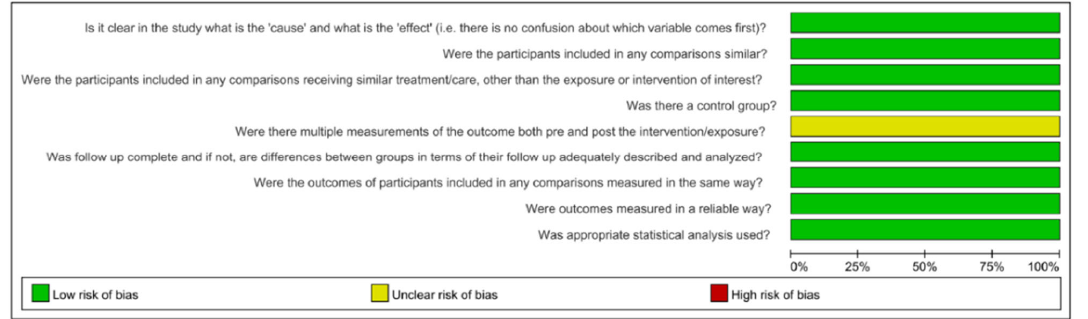
Figure 2. Risk ‐ of ‐ bias summary. Green: low risk of bias; Yellow: unclear risk of bias [15,29,35–43].